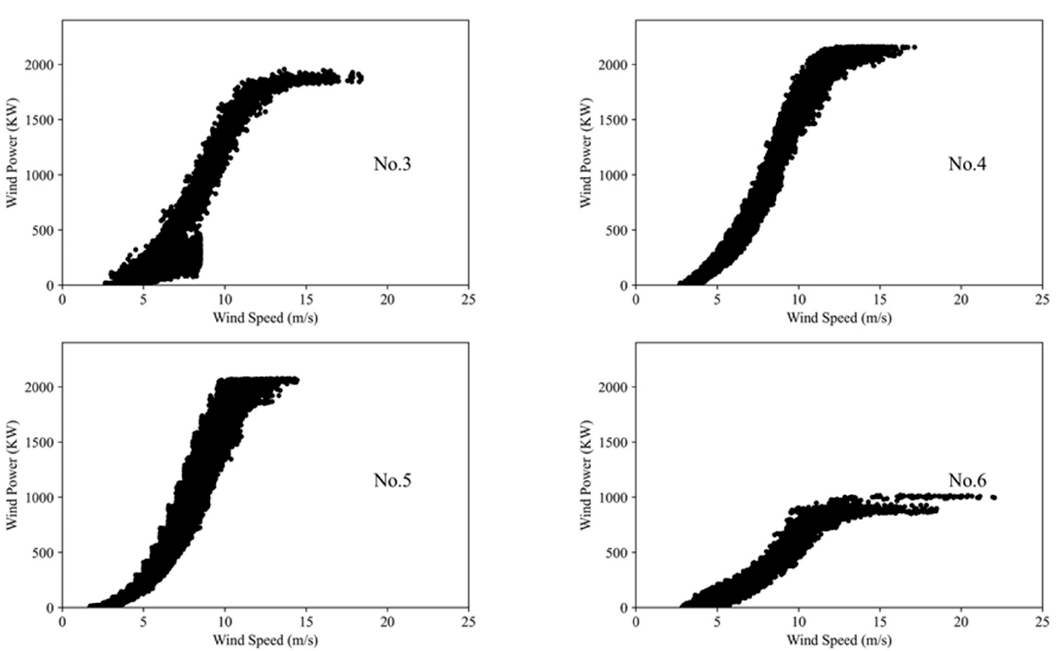
Figure 5. Abnormal data filtering result via QD.